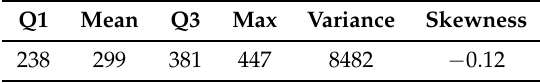
Table 2. Empirical distribution of frequency claim